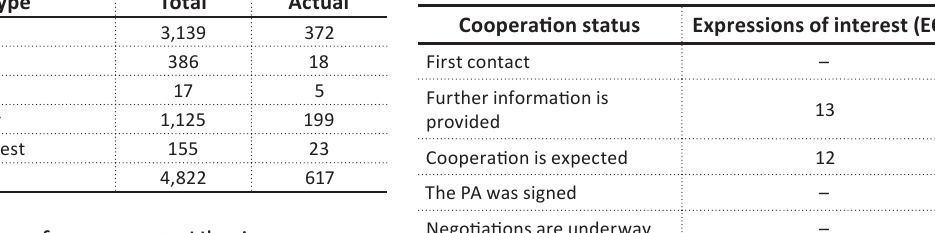
Table 7. Number of requests to Ukraine in the subsectors “Computer graphics” and “3D” for the first half of 2019